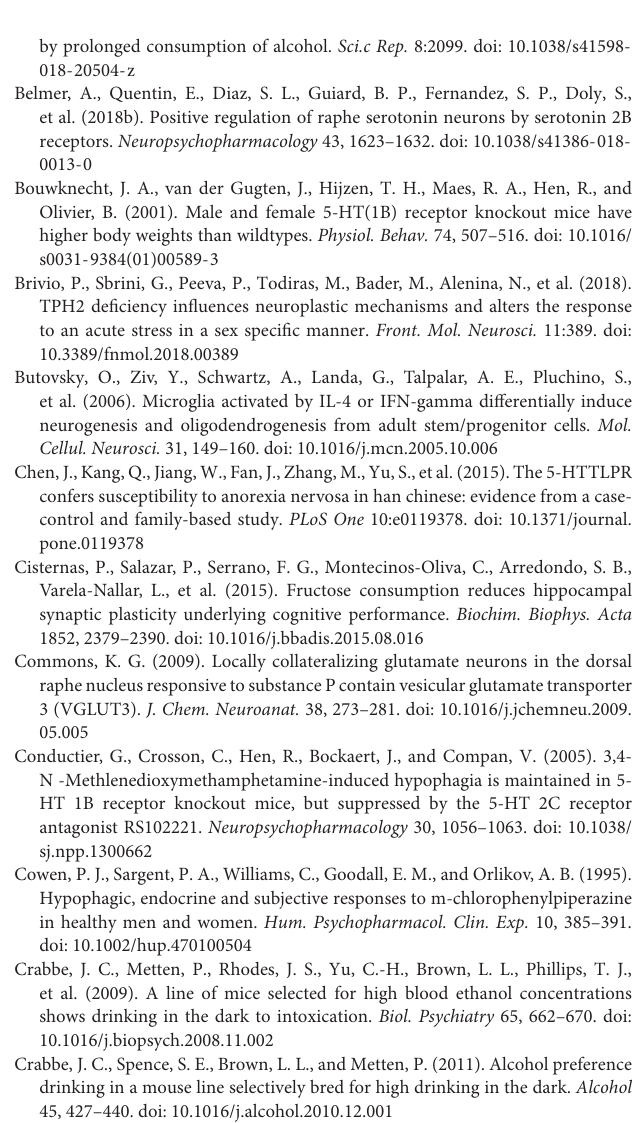
Supplementary Figure 1 | Five percentage sucrose consumption and weight. (A) After 16 weeks of access to 25% sucrose, mice exhibited stable levels of sucrose